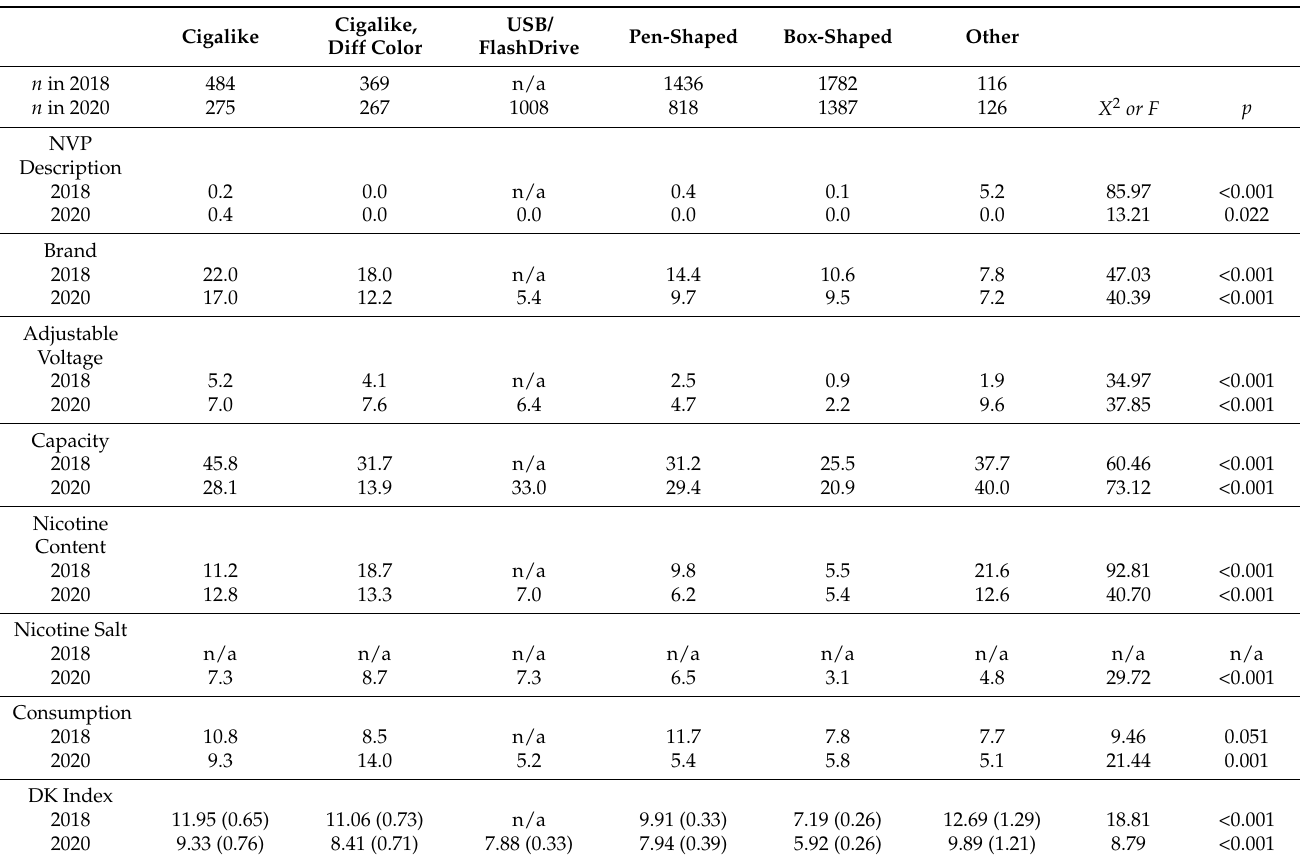
Table 3. DK percentages by NVP